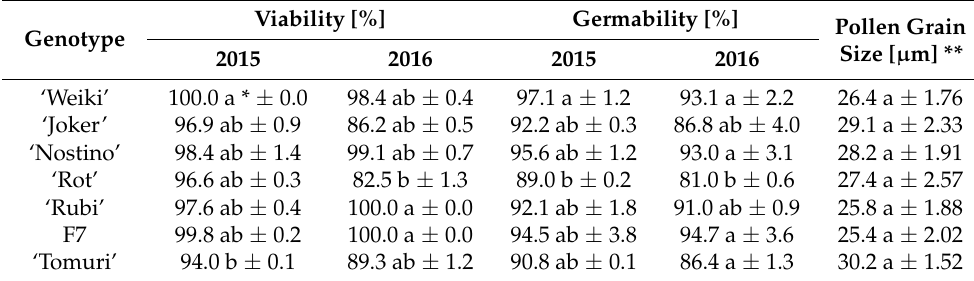
Table 2. Pollen quality and grain size (data represent mean ±